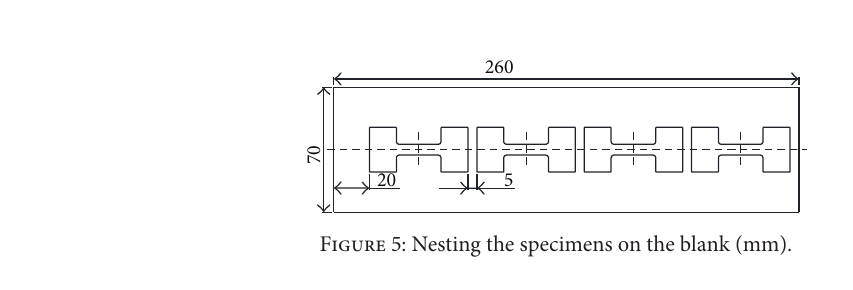
Figure 4: Specimen for the uniaxial test (mm).